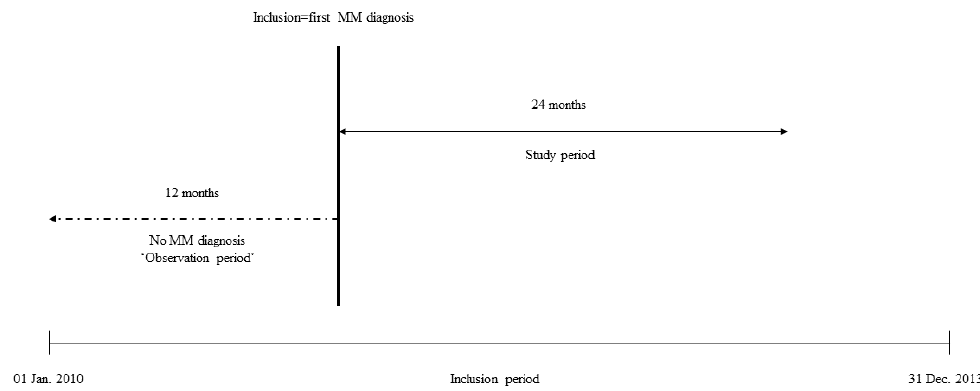
Figure 1. Study design—representation for a given